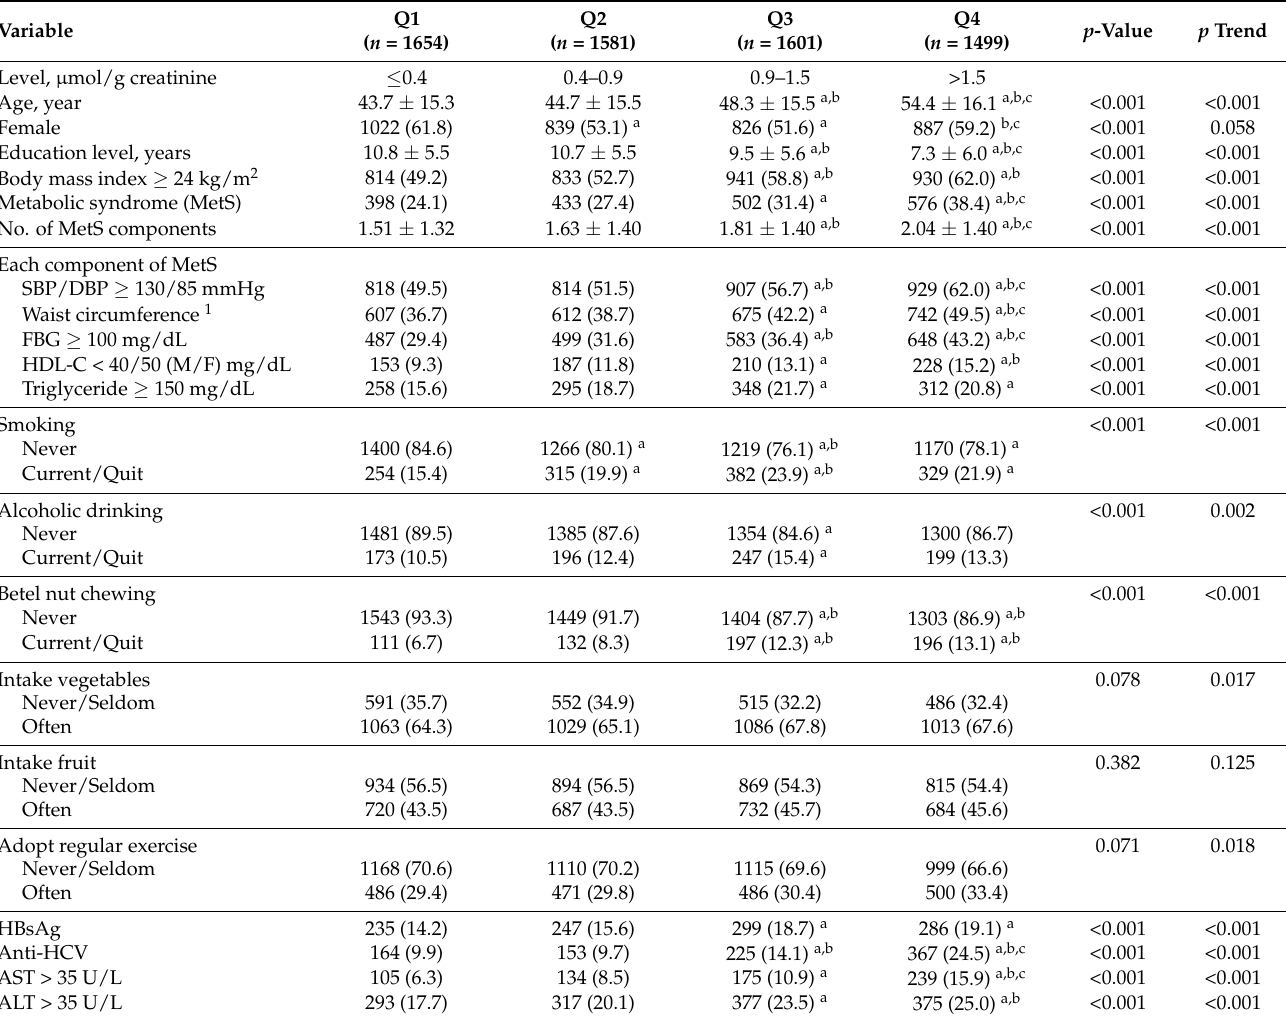
Table 4. Factors associated with the quartiles of urine MDA level ( N =